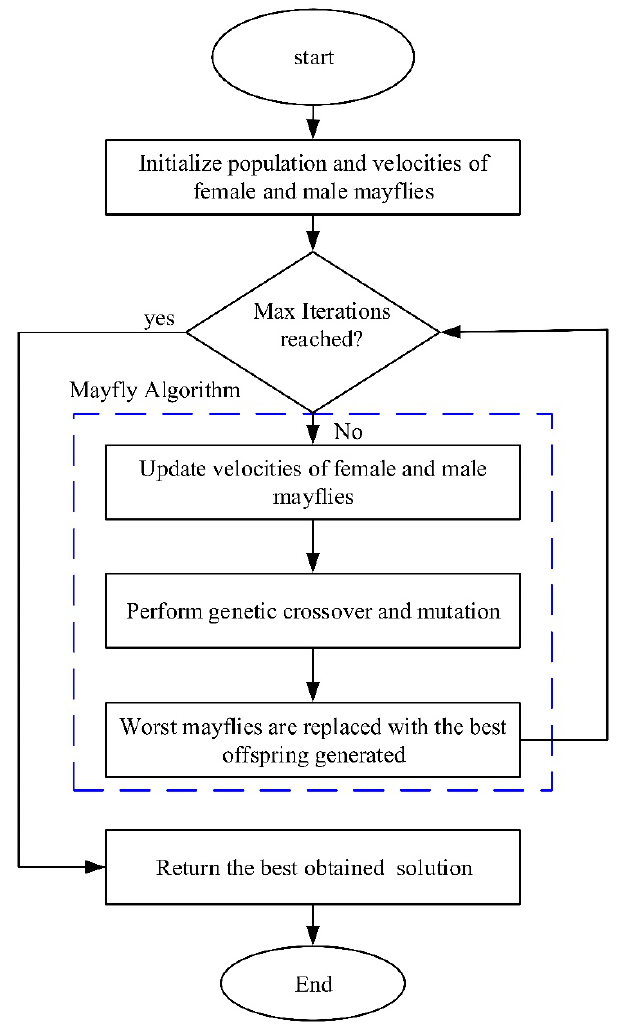
Figure 8. Flowchart of the MA.